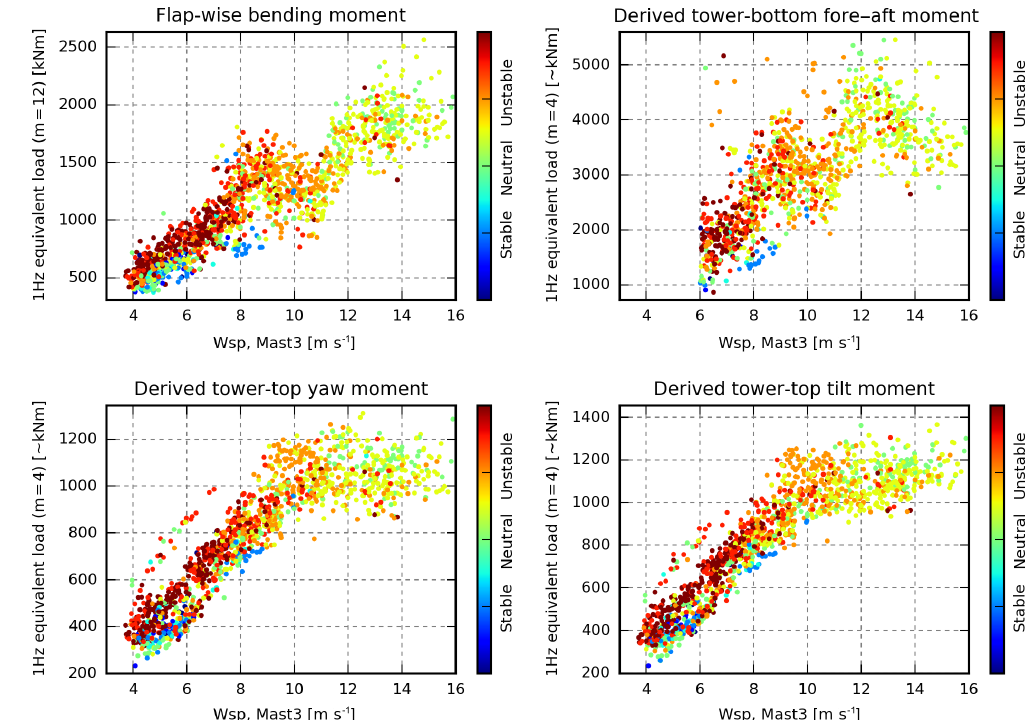
Figure 10. The 1Hz equivalent loads coloured by a atmospheric stability classification metric (i.e. Monin–Obukhov length) extracted from the main met